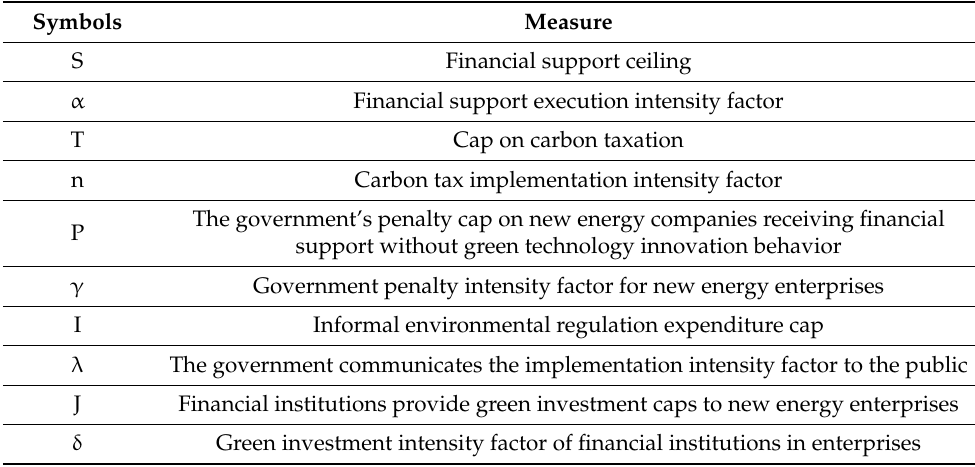
Figure 4. Enterprise green innovation ecosystem impact mechanism. Table 1. Parameter symbols and meanings.